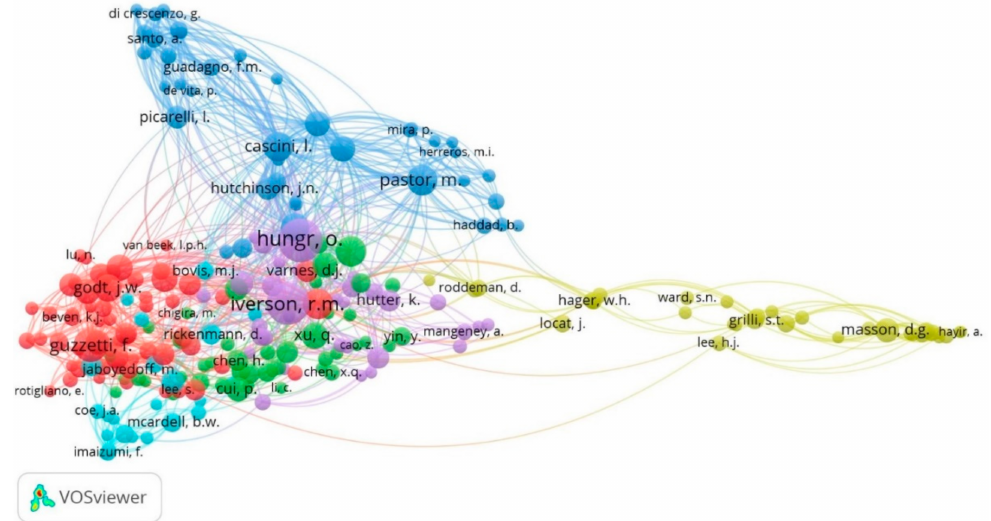
Figure 7. Visualization of the co-citation network assigning a representative color for each cluster. according to the number of interconnected authors. Red, green, blue, yellow, purple and light blue (in order of highest importance by VOSviewer software version